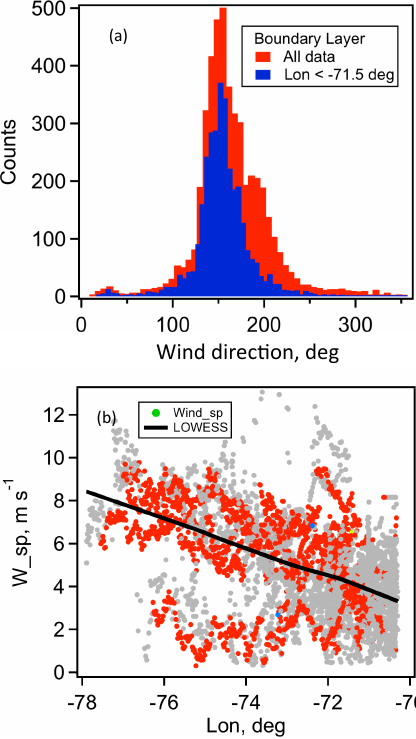
Figure 9. (a) Histogram of MBL wind directions measured on the G-1 during VOCALS showing a consistent southerly near the coast that shifted slightly towards the NNW (155 ◦ ) offshore. (b) Wind speed dependence on longitude where the black line represents the LOWESS smooth, and the data points in red correspond to altitudes less than 150m.